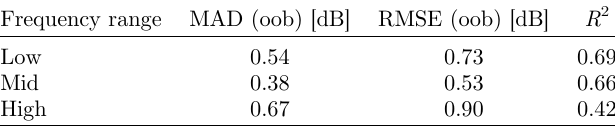
Table 3. Out-of-bag performance parameters for the random forest model based on texture parameters: mean absolute deviation (MAD), root mean squared error (RMSE) and coef fi cient of determination ( R 2 ) for the three frequency ranges.